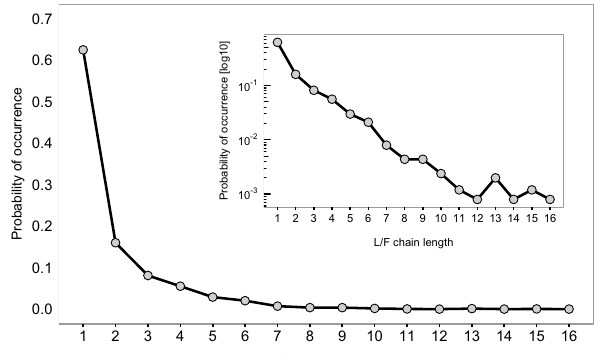
Figure 3. Probability distribution of the lengths of L/F event chains,calculated over all nine datasets. Inset: log- linear plot of